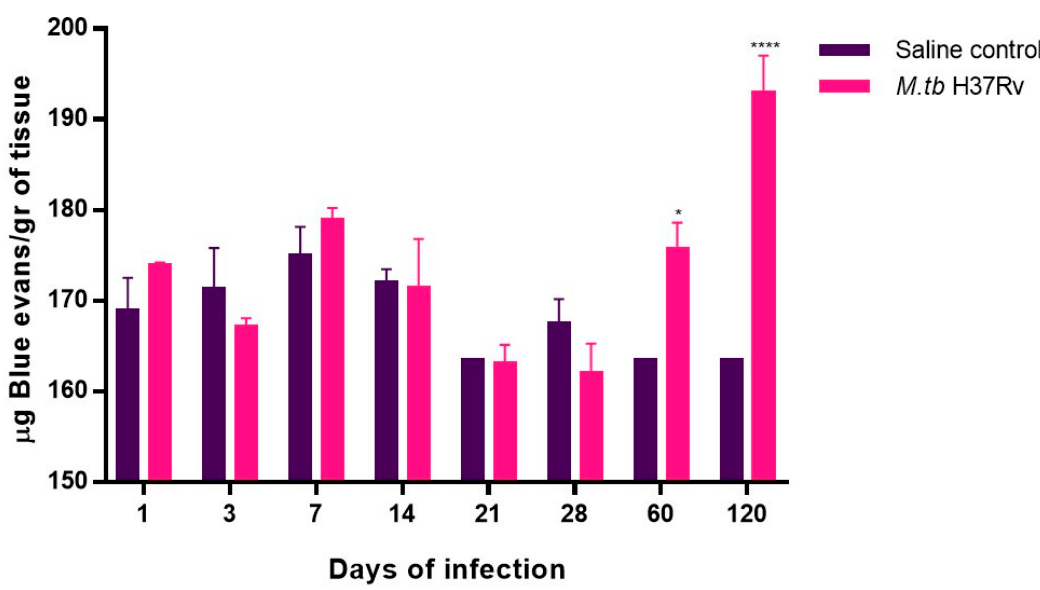
Figure 9. Advanced TB enhanced blood–brain barrier permeability in BABL / c mice. Simple e ff ects analyses revealed increased extravasation of EB in the infected group at 60 and 120 days post-infection compared with the saline control. Data are expressed as mean ± SEM. F (1, 4) = 23.45, p = 0.0084, two-way ANOVA; * p < 0.01, **** p < 0.0001, Sidak’s multiple comparisons test ( α = 0.05) ( n =